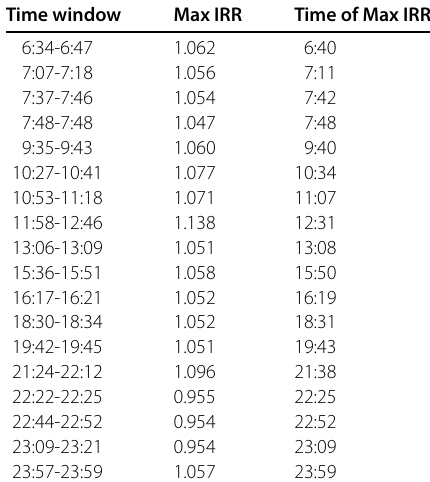
Table 1 Time-windows where the Pokémon Go effect was significant. Each window includes its maximum Incidence Rate Ratio (IRR) and its corresponding time of the